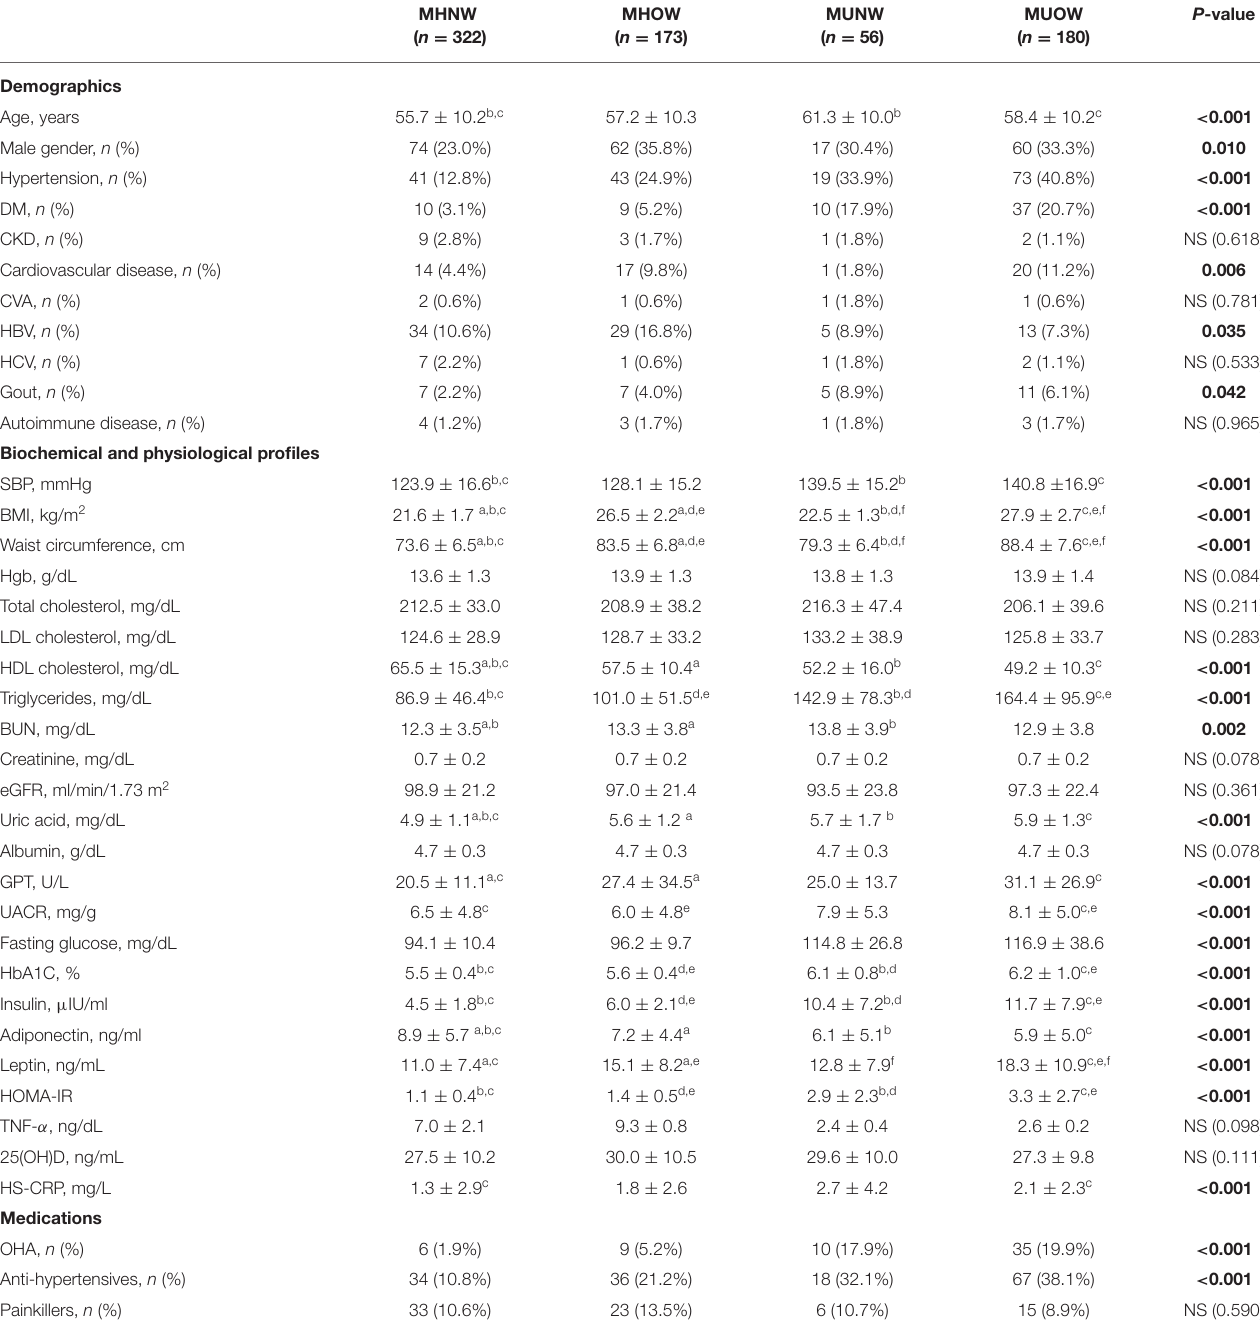
TABLE 2 | Baseline characteristics of the population, stratified by metabolic body composition